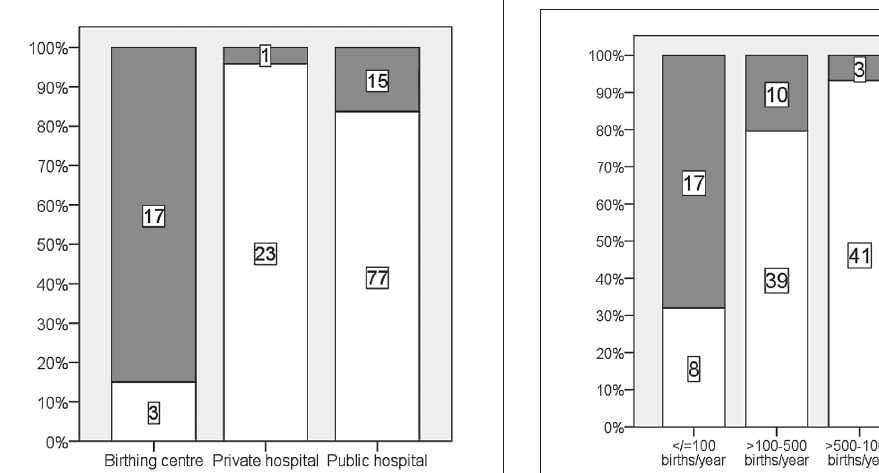
Screening rate by category of maternity unit; n = 136 (birthing centre: n = 20; private hospital: n = 24; public hos- pital: n = 92). Percentage (indexed on the left) of units with regular PO screening (white) and without (grey).